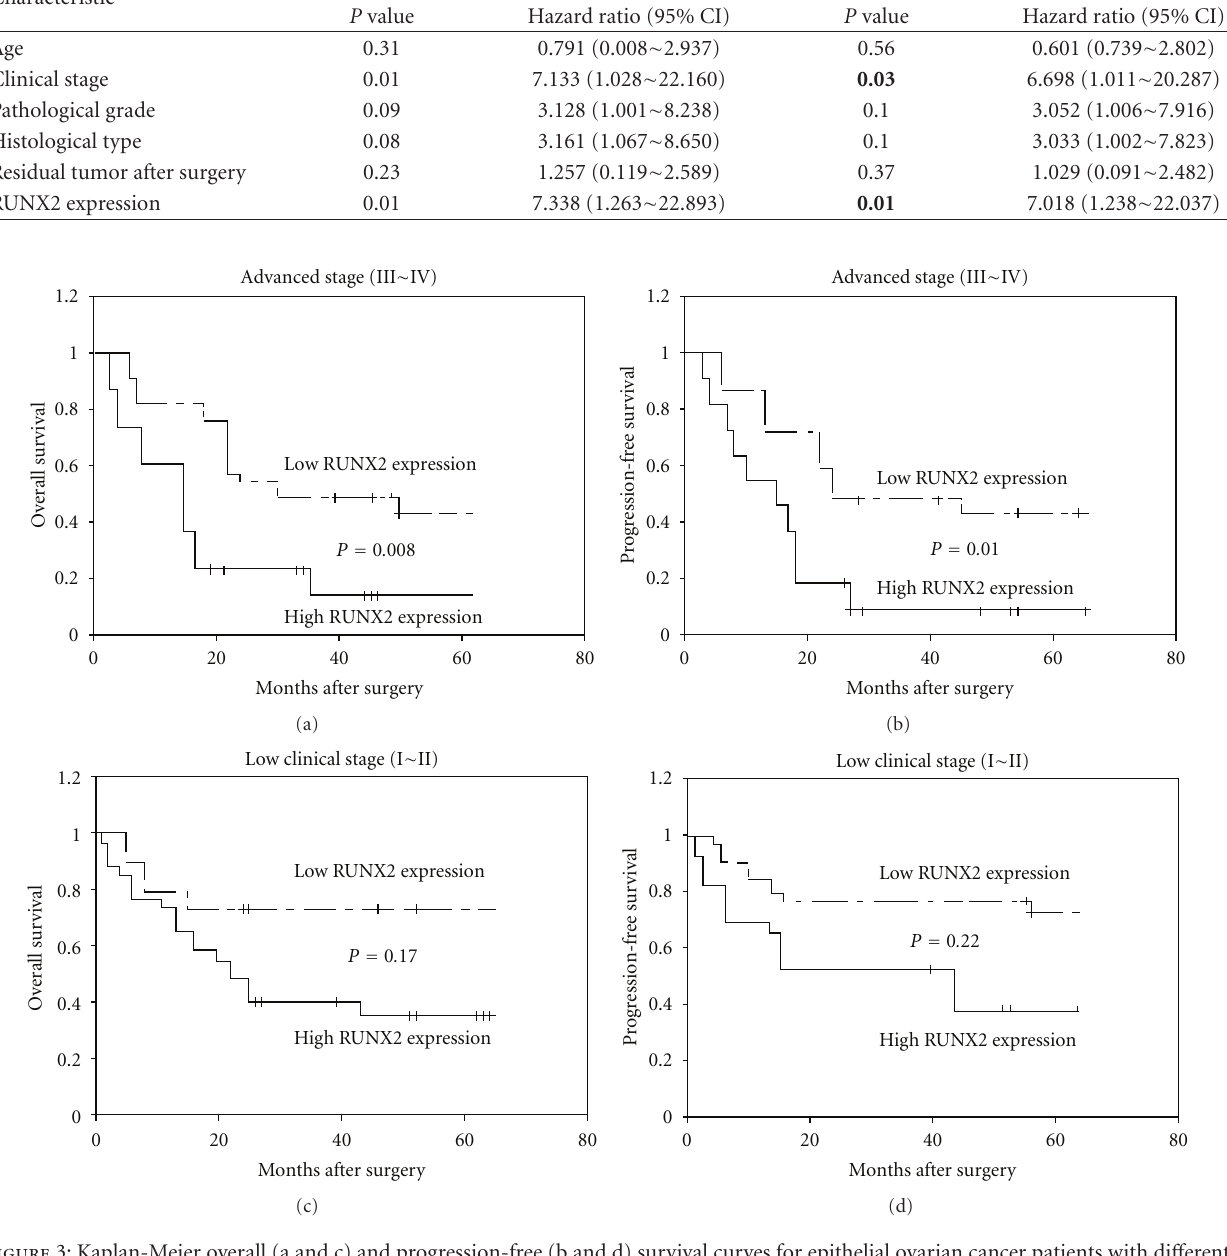
Figure 3: Kaplan-Meier overall (a and c) and progression-free (b and d) survival curves for epithelial ovarian cancer patients with di ff erent clinical stages. Subgroup analyses according to clinical stage revealed that epithelial ovarian cancer patients with high clinical stages (III ∼ IV) in high RUNX2 expression group demonstrated a significantly worse clinical outcome than those in low RUNX2 expression group (a and b), but patients with low clinical stages (I ∼ II) had no significantly di ff erent prognosis between high and low RUNX2 expression groups (c and